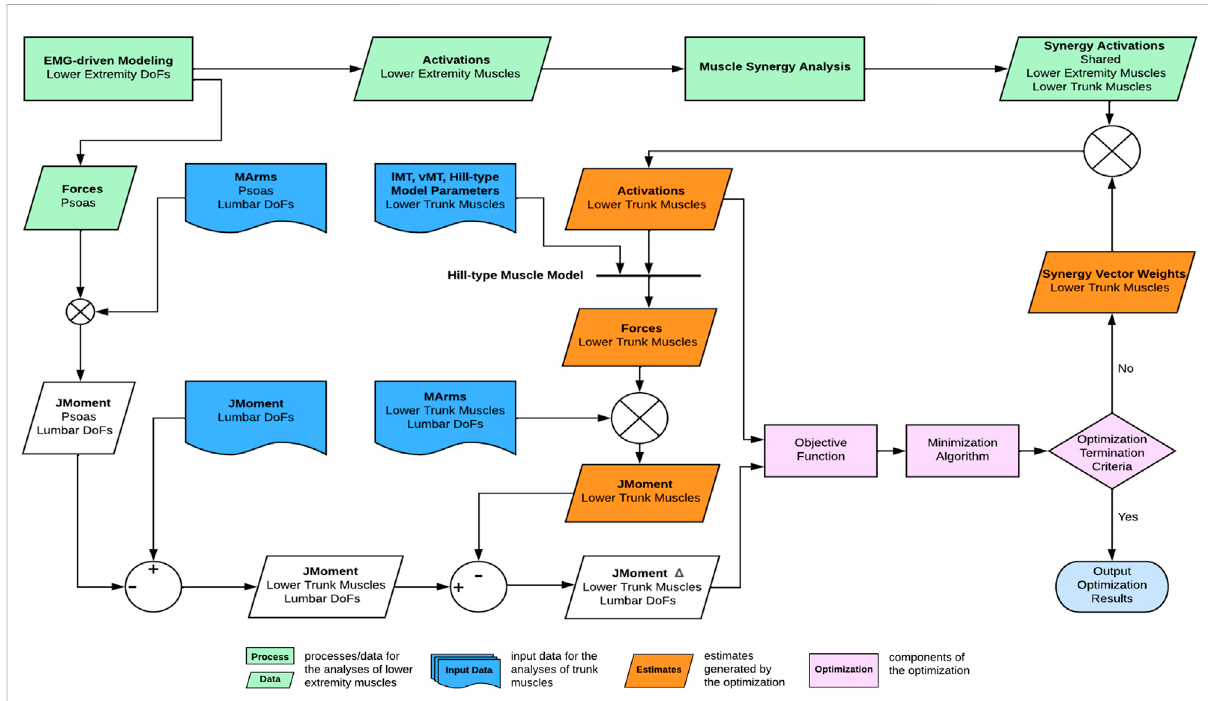
FIGURE 3 Overview of the computational framework used to estimate trunk muscle activations and forces. From lower extremity muscle activations, muscle synergies were extracted and of which, the synergy activations were then combined with synergy vector weights of the trunk muscles that were searched iteratively by the optimization until the optimal solution of trunk muscle activations was